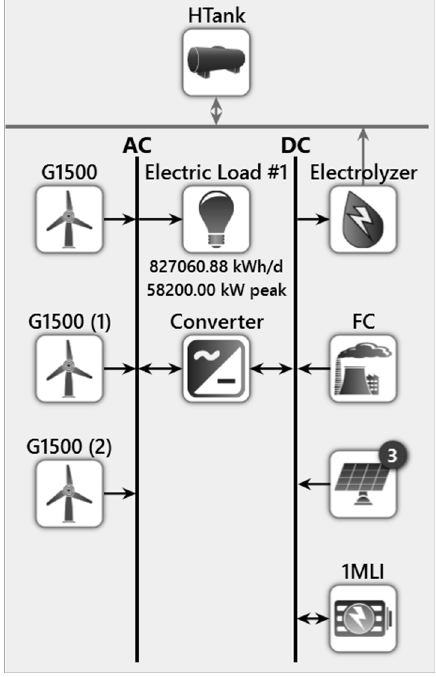
Figure 12. Schematic diagram of wind-PV-FC-Battery system.